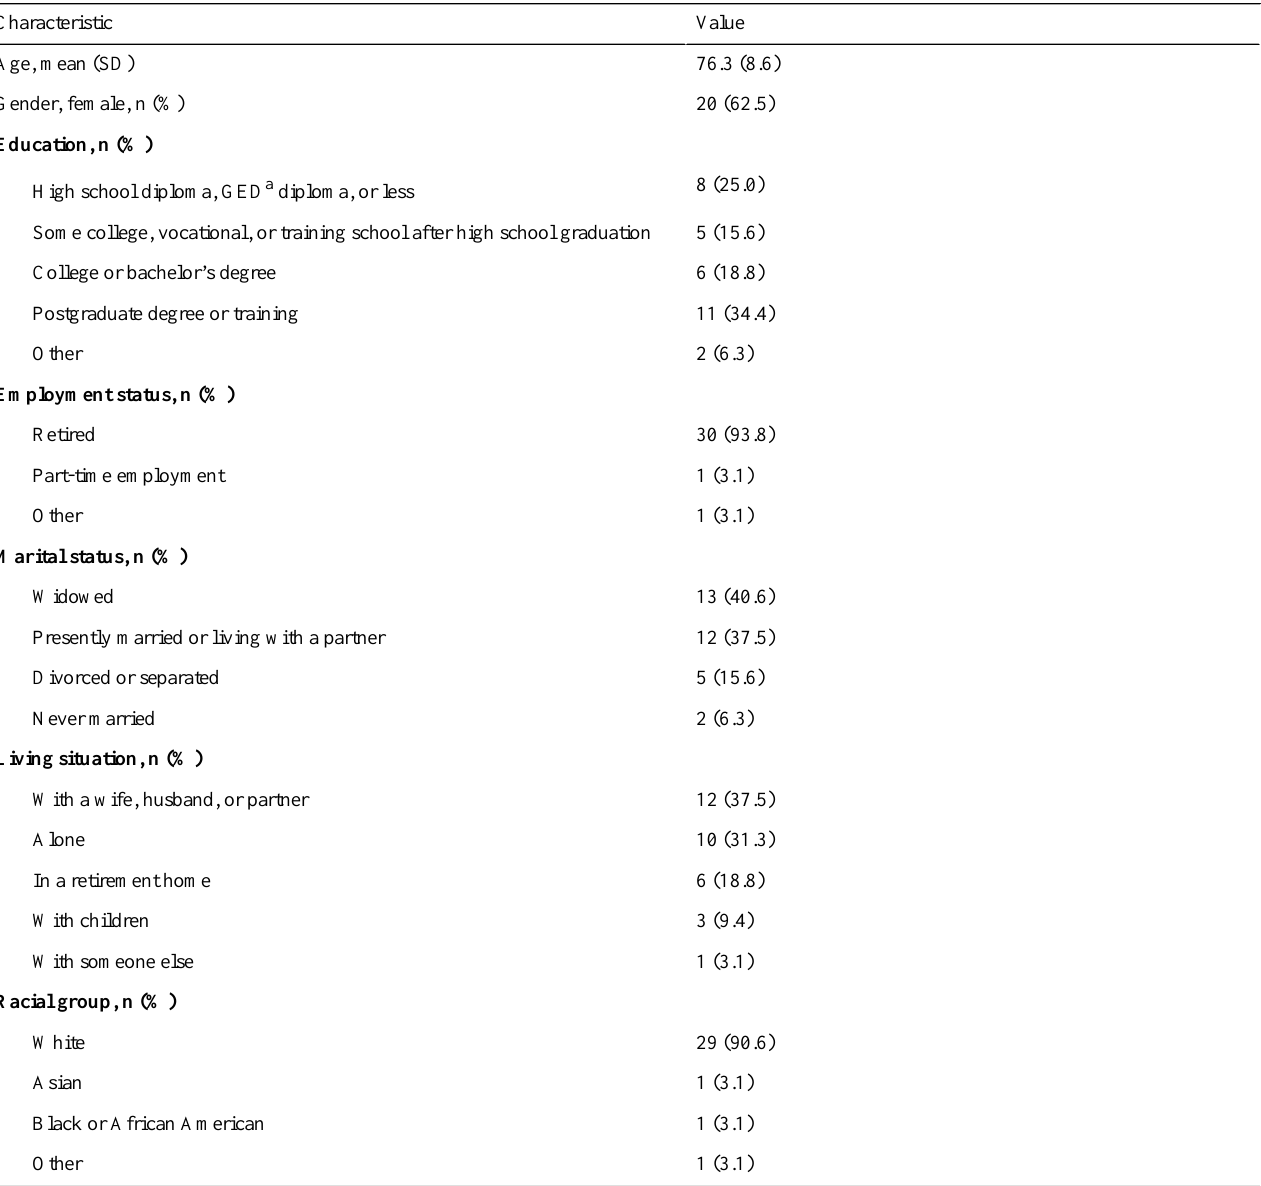
Table 1. Descriptive characteristics of the study participants at baseline